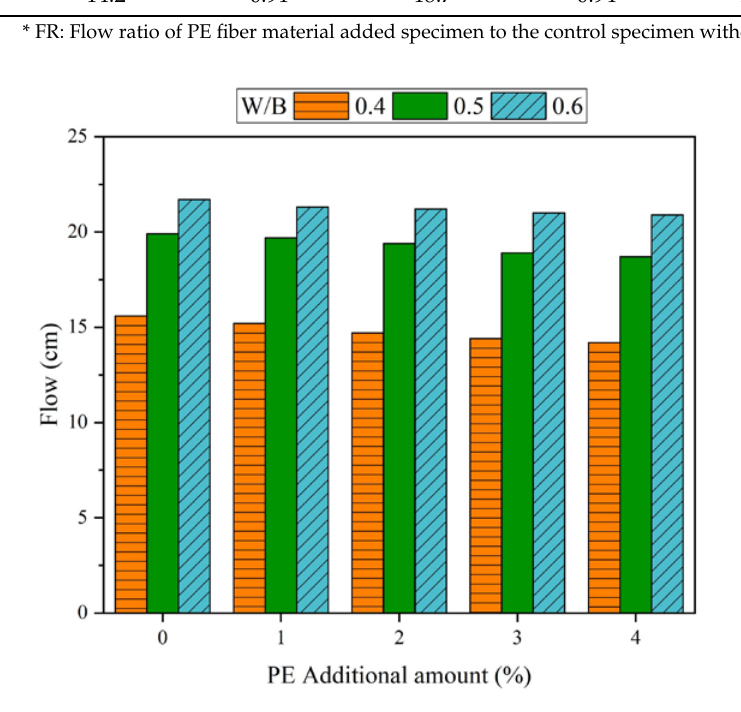
Figure 3. Flow of cement mortar with different W/B ratios and waste PE.